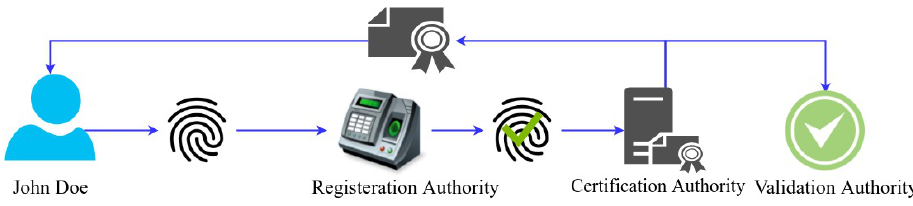
Figure 8. Digital Certification Authority Issues Digital Certificate After Verification of the